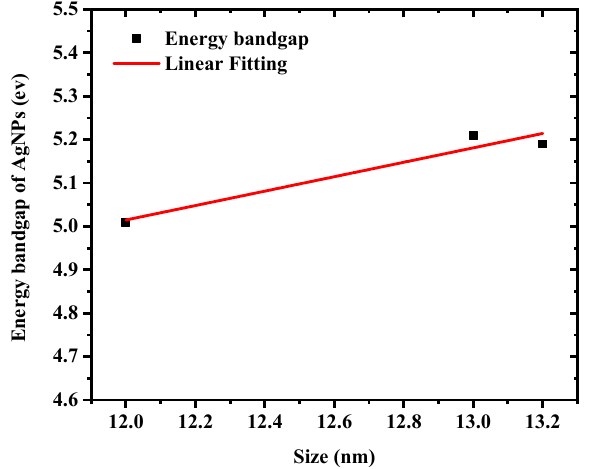
Figure 6. Dependence of bandgap energy on average size of AgNP colloids.